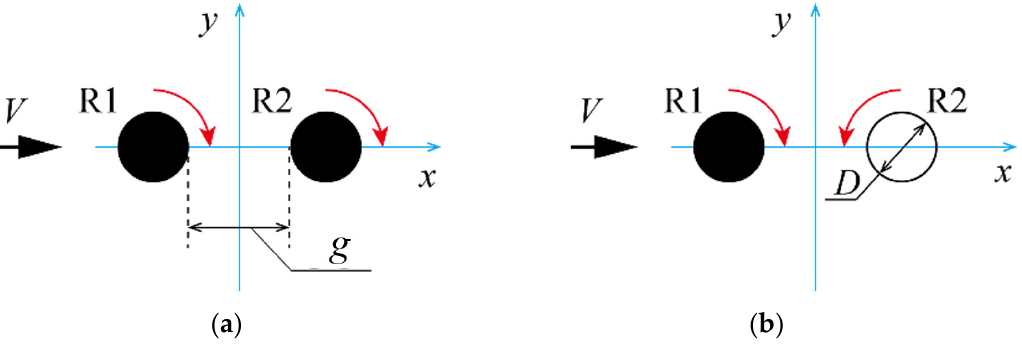
Figure 2. Two tandem layouts against the wind direction in a closely spaced VAWT pair: ( a ) tandem co-rotating (TCO); ( b ) tandem inverse-rotating (TIR).